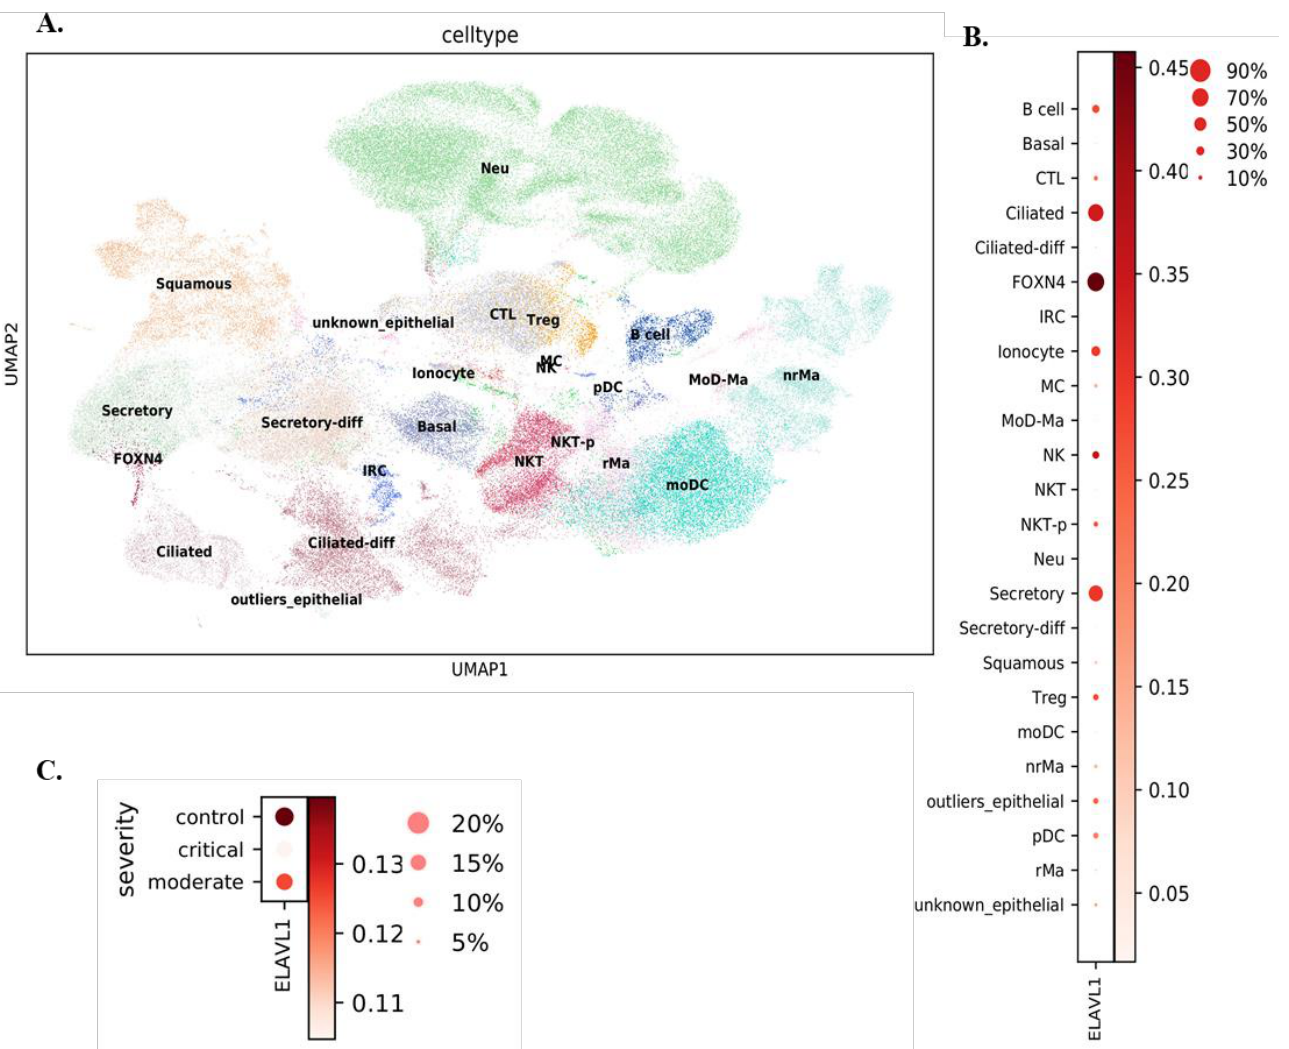
Figure 1. ELAVL1 single-cell level expression in nasopharyngeal and bronchial cells. ( A ) Different cell populations in an existing single-cell RNA-seq data [30] were analyzed as described in the Materials and Methods. ( B ) Dotplot representing the expression of ELAVL1 in different cell populations. The size of the circle denotes the % of cells expressing the ELAVL1 gene. The darkness of the circle shows the expression level. The expression of ELAVL1 is significantly higher (Mann–Whitney U test, p -value = 0) in ciliated, FOXN4, secretory cells than that in any other cells. ( C ) The expression of ELAVL1 is significantly lower (Mann–Whitney U test, p -value = 4.41 × 10 − 23 ) in critical COVID-19 patients than in moderate and control patients.